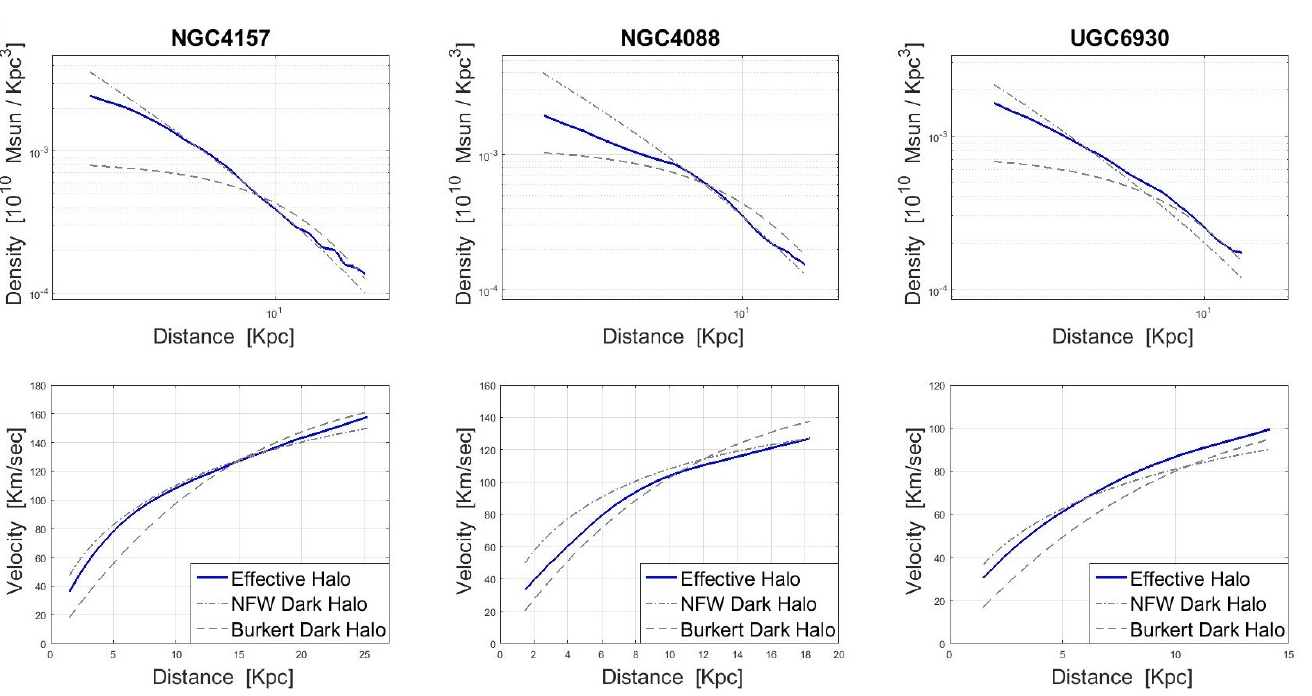
Figure 3. Density distributions of Burkert, NFW, and the effective halo are plotted in the upper panels. The corresponding rotational velocities are given in the lower panels. The Burkert and the NFW halos use two free parameters: The virial mass, Mvir [10 10 Msun] and the concentration parameter, c. The effective halo has one parameter, namely ω [10 − 16 rad/s]. Left Panels: NGC 4157 (NFW: Mvir = 170 , c = 5; Burkert: Mvir = 120 , c = 12; effective halo: ω = 1.12). Middle Panels: NGC 4088 (NFW: Mvir = 70 , c = 7; Burkert: Mvir = 70 , c = 13.5; effective halo: ω = 1.04). Right Panels: UGC 6930 (NFW: Mvir = 40 , c = 5; Burkert: Mvir = 30 , c = 11.5; effective halo: ω =